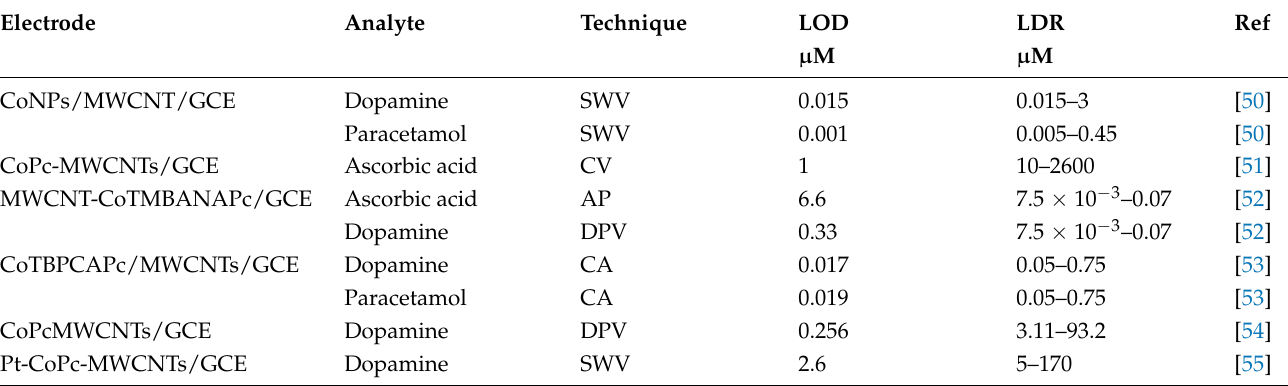
Table 1. Detection of ascorbic acid, dopamine, and paracetamol with CoPc-MWCNTs modified